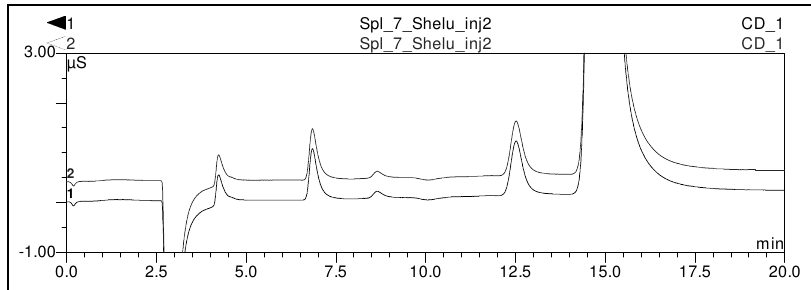
Figure 10. Conductivity detection of sample_7_Shelu for arsenate content (duplicate